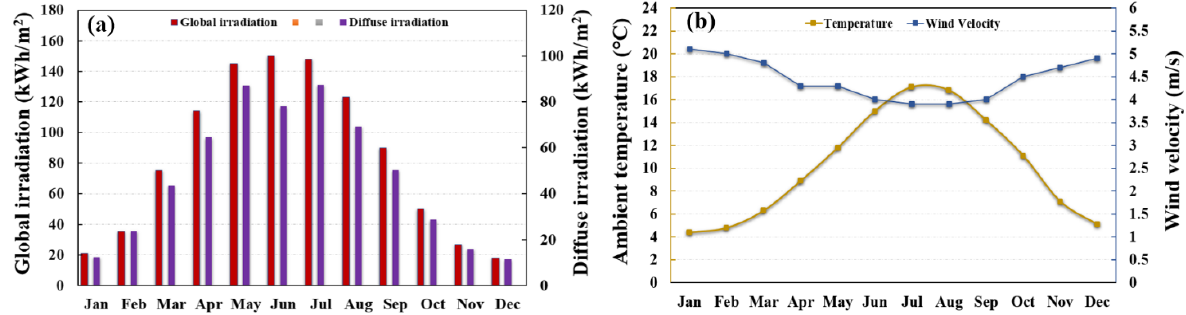
Figure 2. Weather circumstance: ( a ) global and diffuse irradiation; ( b ) air temperature and wind velocity in Derby, UK.